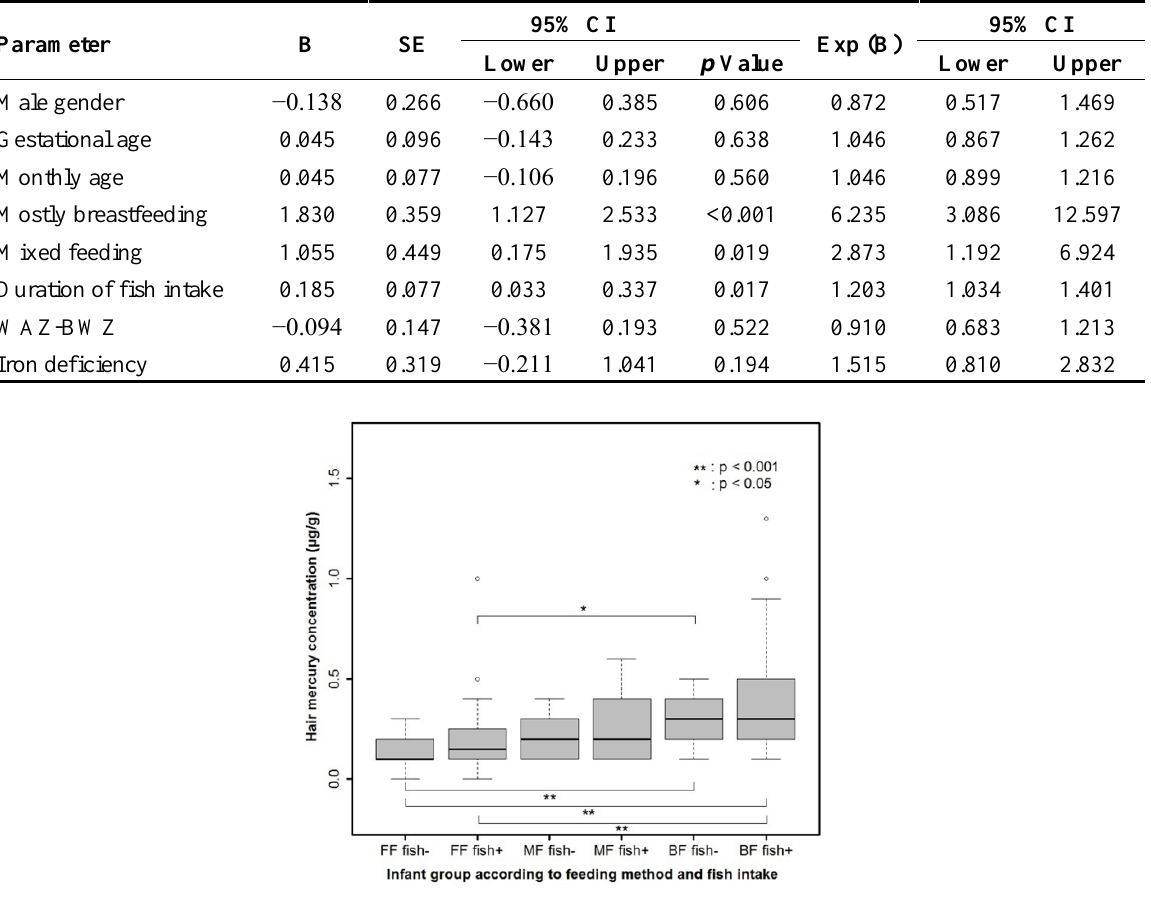
Figure 3. Hair mercury content in six categorized groups of infants according to the feeding method and fish intake ( p < 0.001). FF: mostly formula feeding, MF: mixed feeding, BF: mostly